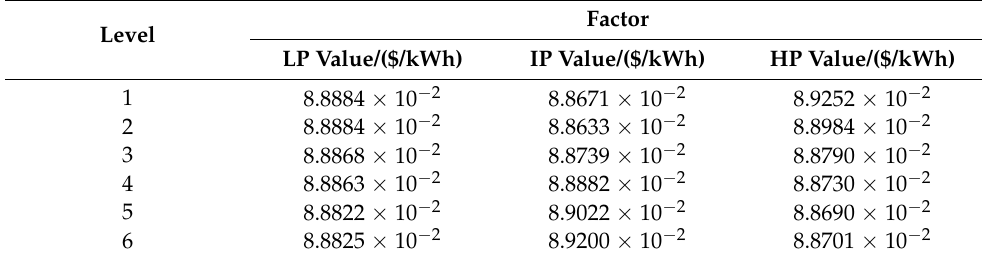
Table 9. The average power generation cost under all levels (GT 100% load